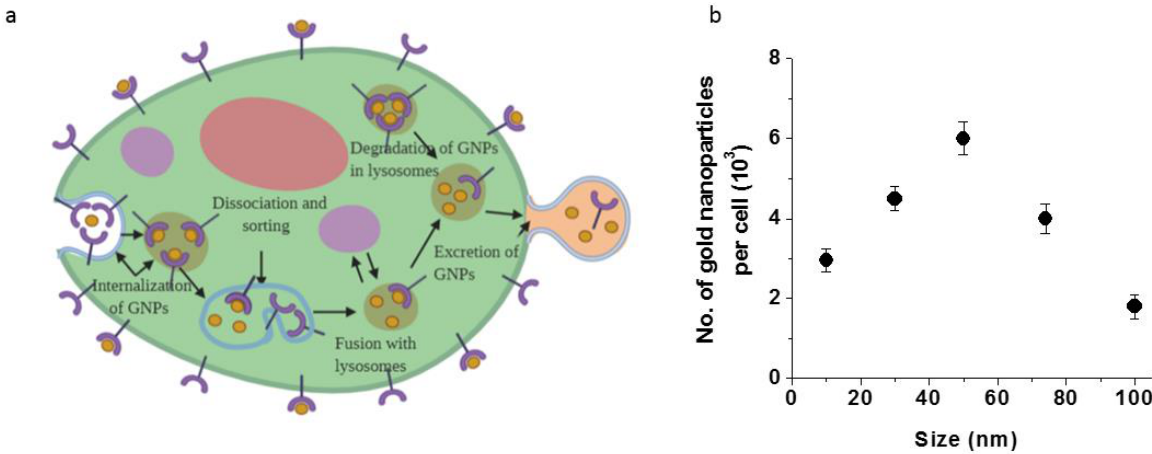
Figure 2. Cellular uptake of GNPs. ( a ) Endo-lyso pathway of GNPs; GNPs are internalized via endocytosis, get processed, and then get excreted out of the cell [7]. ( b ) Size-dependent uptake of GNPs. Reproduced with permission from [13], American Chemical Society, 2006.